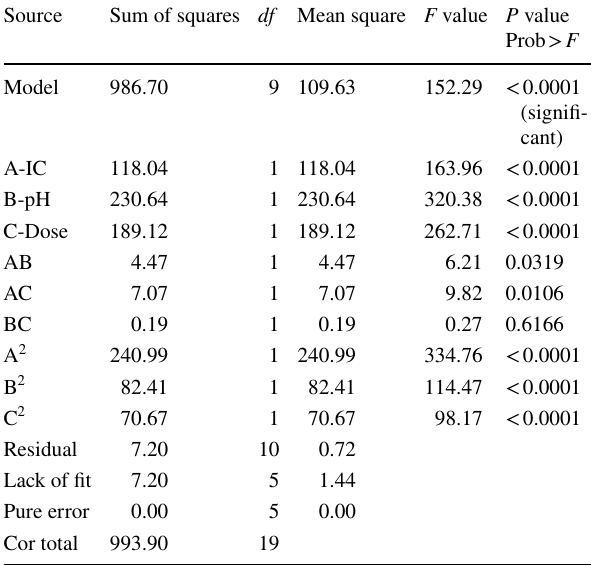
Table 6 ANOVA for response surface quadratic model